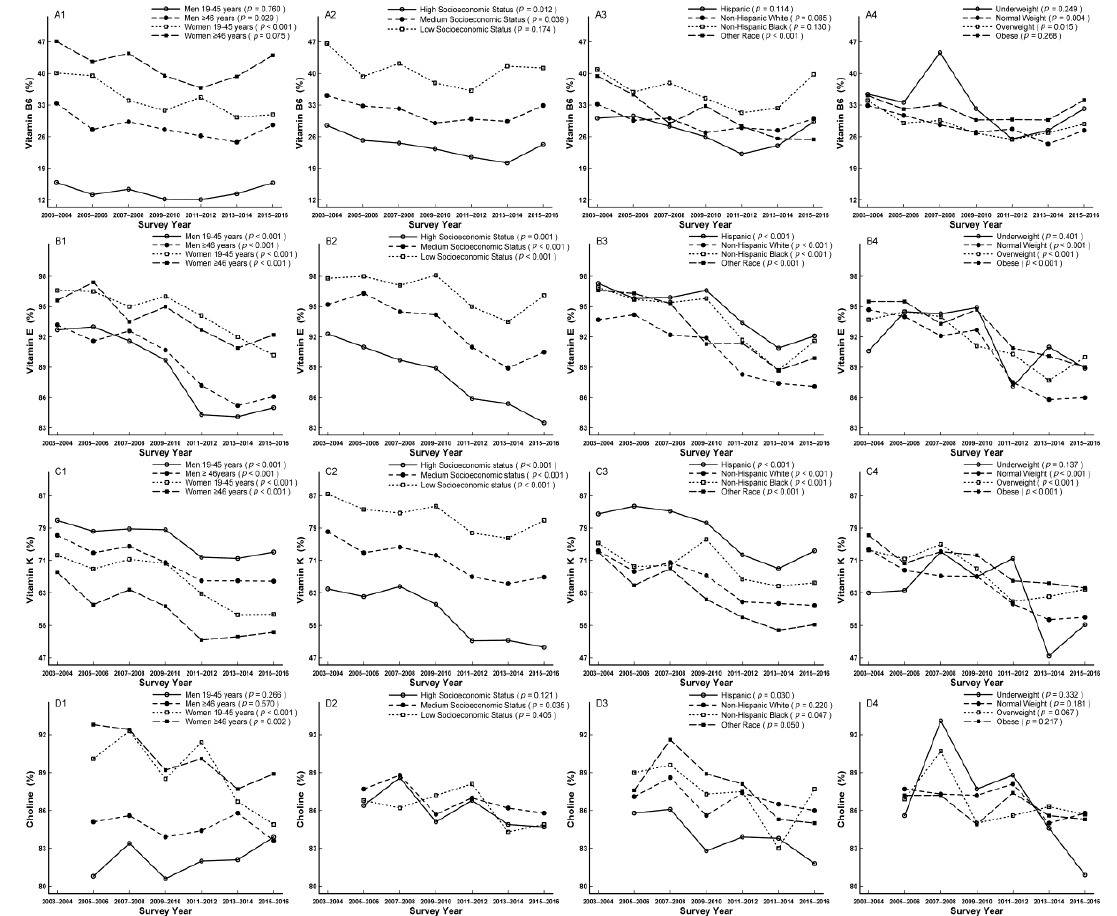
Figure 4. Trends of dietary vitamin B6 (A1–A4), vitamin E (B1–B4), vitamin K (C1–C4), and